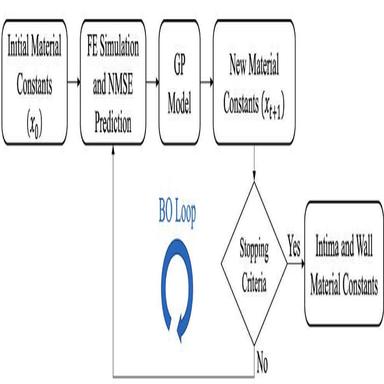
A high-level summary of the Bayesian Optimization framework.